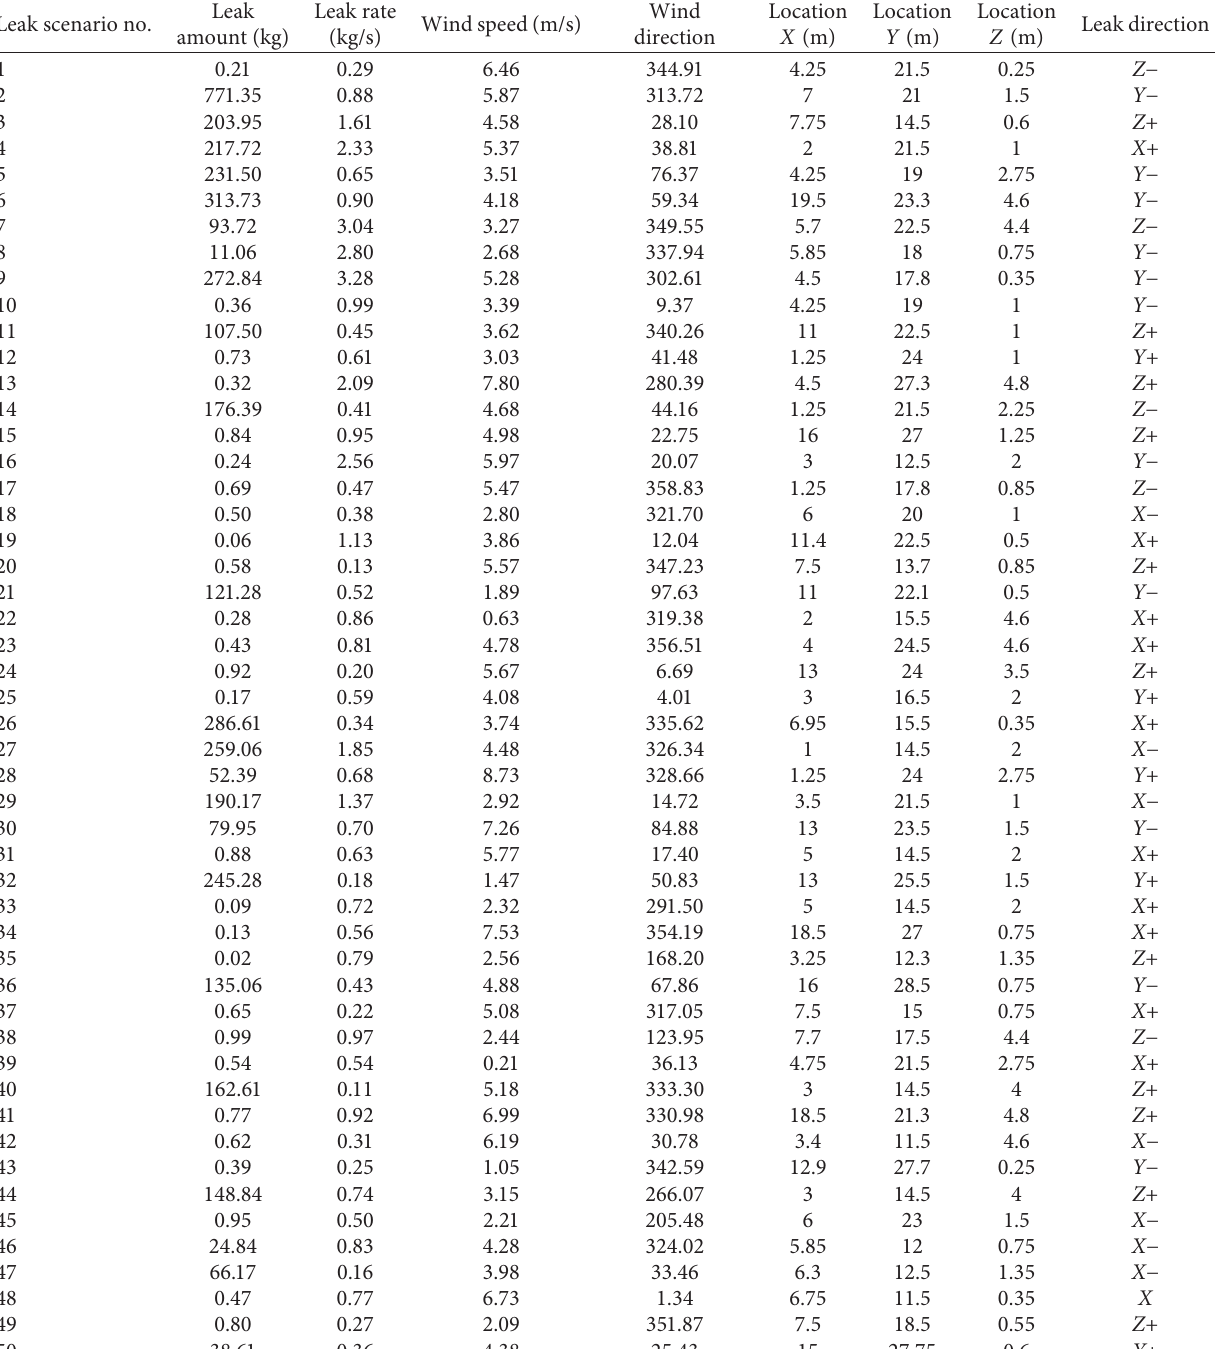
Table 3: 50 Leak scenarios sampled by LHS